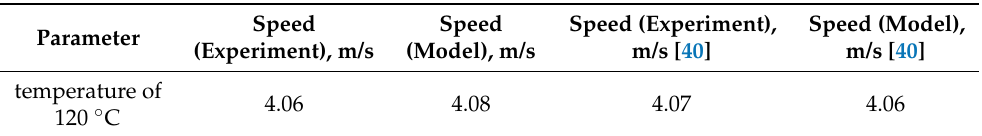
Table 7. Comparison of the authors’ experimental data and simulation results [40] at the temperature of 120 ◦